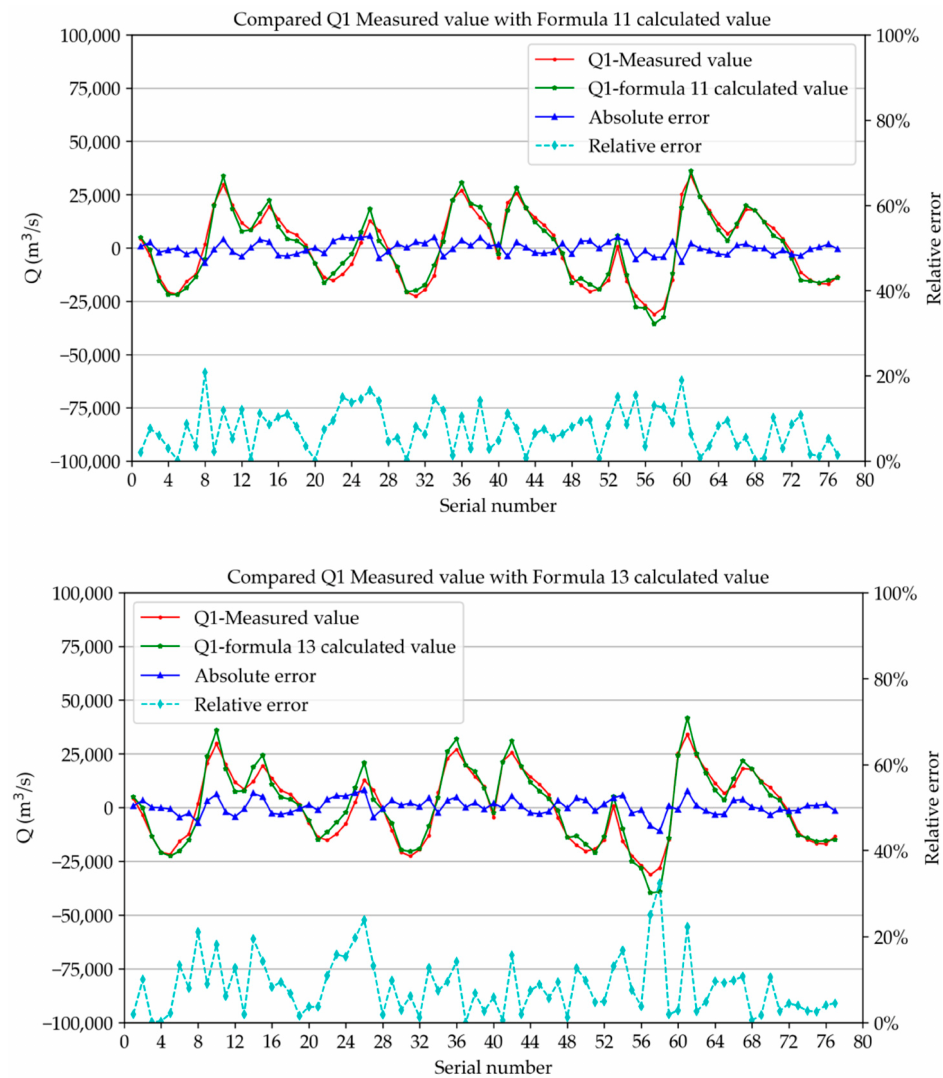
Figure 13. Comparison between Q 1 measured value and calculated value of